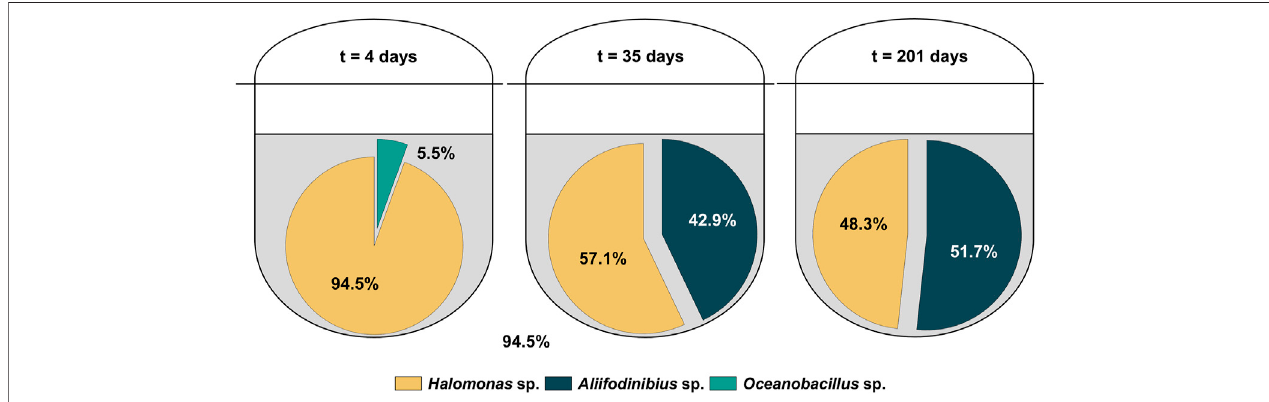
FIGURE 2 | Readout distribution from Amplicon Deep Sequencing of the halophilic microbial community after 4, 35 and 201 days of